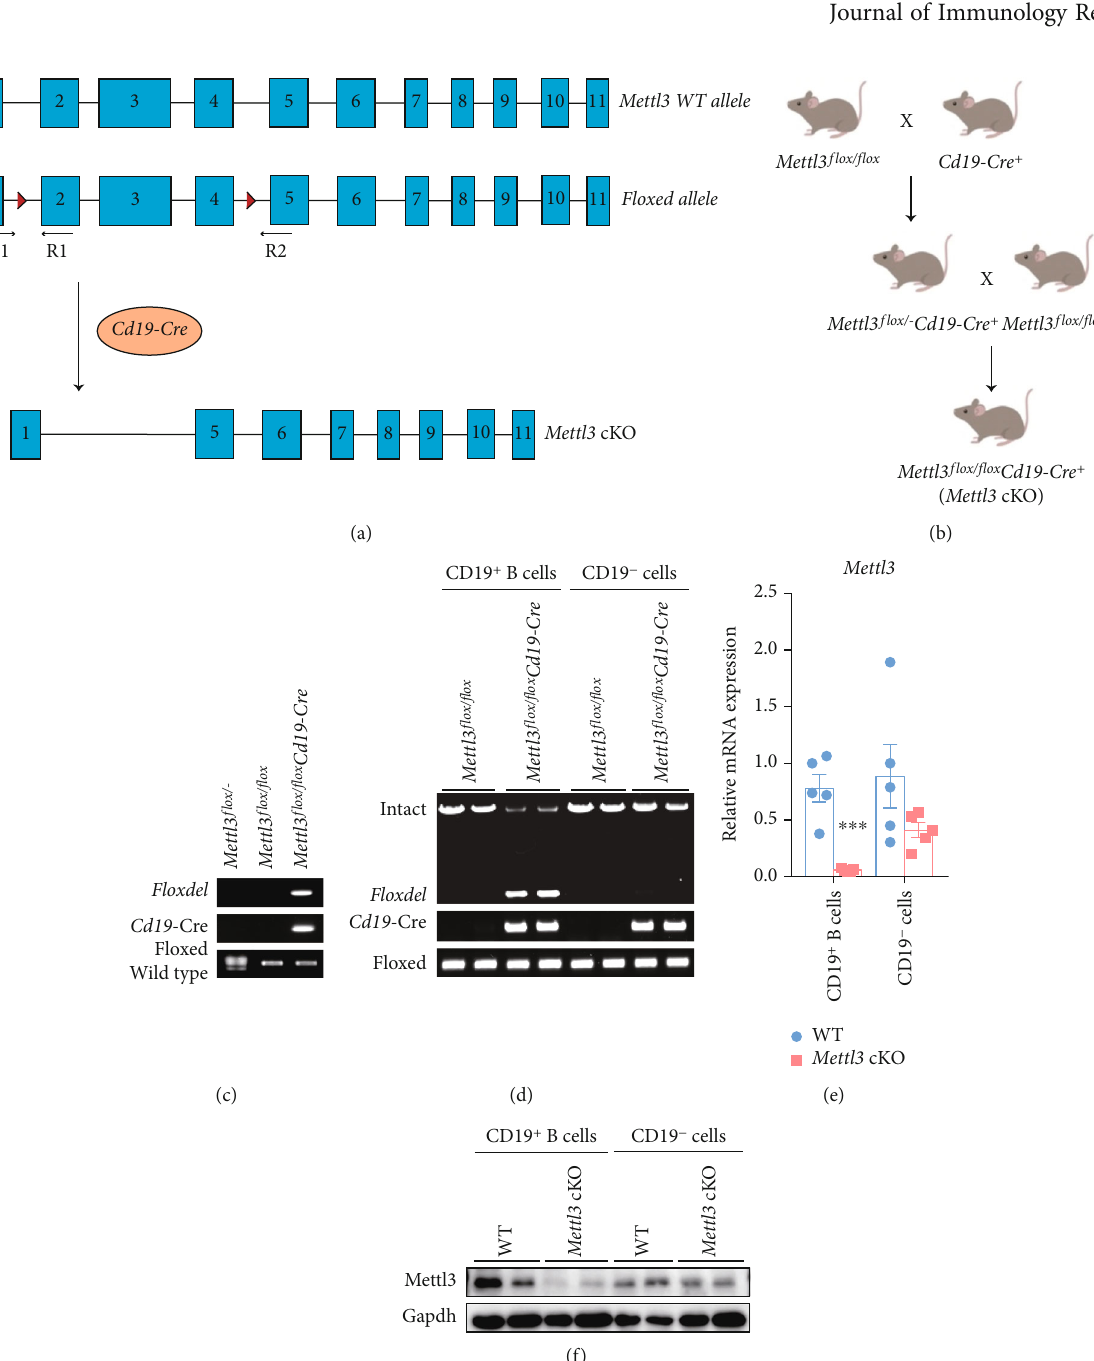
Figure 1: Construction and characterization of B cell-speci fi c Mettl3 knockout mice using Cd19-Cre. (a) Strategy of Cd19-Cre -mediated Mettl3 knockout mouse construction. Floxed-Mettl3 allele was generated by fl anking exons 2 and 4 with loxP sites. B cell-speci fi c Mettl3 knockout mice ( Mettl3 cKO) were obtained by crossing fl oxed-Mettl3 mice with Cd19-Cre transgenic mice. (b) Schematic diagram of breeding strategies of Mettl3 cKO mice. (c) Genomic PCR for the tail of indicated genotype. The top lane ( fl oxdel) showed the exon 2-4 deleted alleles (ampli fi ed using Mettl3-F1 and Mettl3-R2 primer shown in (a)). The middle lane ( Cd19-Cre ) showed the e ff ective insertion of Cd19 promoter-driven Cre . The bottom lane displayed genotyping of heterozygous ( Mettl3 fl ox/- ) or homozygous ( Mettl3 fl ox/ fl ox ) fl ox fl anking alleles (ampli fi ed by Mettl3-F1 and Mettl3-R1 primer shown in (a)). (d) Genomic PCR analysis for CD19 + B cells and CD19 - cells isolated from the spleen of mice with indicated genotype. Intact (upper) and fl oxdel (lower, with the exon 2-4 deleted alleles) lanes were ampli fi ed using Mettl3-F1 and Mettl3-R2 primer shown in (a). (e) qRT-PCR for Mettl3 of CD19 + B cells and CD19 - cells isolated from WT and Mettl3 cKO mouse spleen. (f) Western blot for Mettl3 of CD19 + B cells and CD19 - cells isolated from WT and Mettl3 cKO mouse spleen. Data in (e) were presented as means ± SEM with the indicated signi fi cance ( ∗∗∗ P < 0 : 001 ; student ’ s t